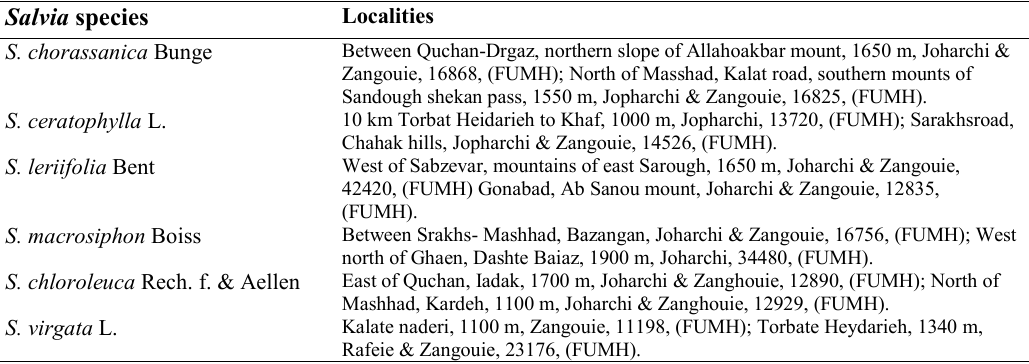
Table 1. The localities of the studied Salvia species.